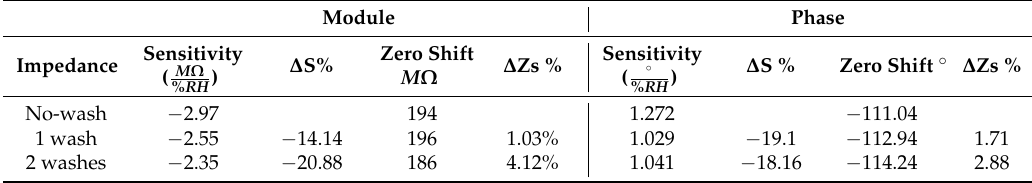
Table 2. Relation between the parameters measured and the relative humidity.